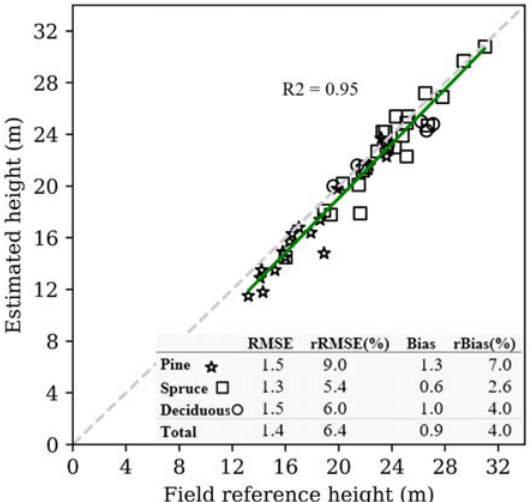
Figure 9. Mean tree height estimation (meter) using local maxima method with LML data per each and all species classes.